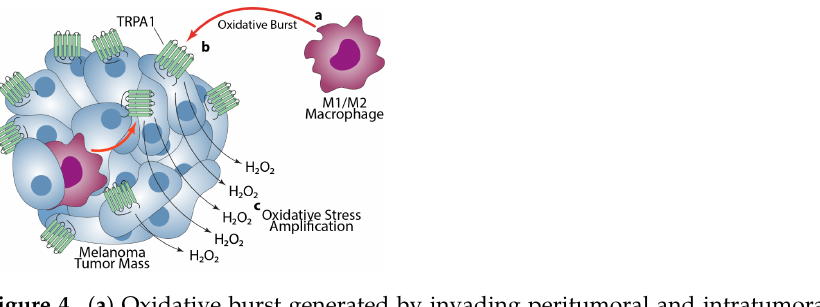
Figure 4. ( a ) Oxidative burst generated by invading peritumoral and intratumoral, M1 and M2 macrophages ( b ) targets TRPA1 on melanoma cells which ( c ) amplifies the oxidative stress (H 2 O 2 ) signal to favor tumor